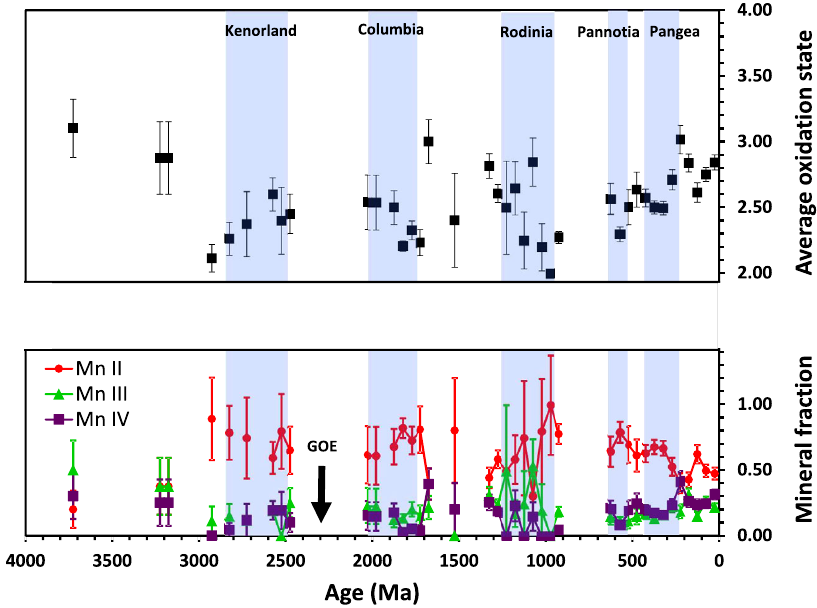
Fig. 2 Individual and average Mn oxidation states as a function of geologic time. Graph of fraction of Mn mineral occurrences (lower) and average Mn oxidation state (upper) as a function of geologic time, with data parsed into 50 million-year bins. Colored symbols indicate oxidation state of Mn; Red circles = Mn(II), Green triangles = Mn(III), Purple squares = Mn(IV). Blue bands represent intervals in which Earth ’ s major landmasses are thought to have consolidated into a supercontinent. Uncertainties for oxidation state fractions are standard deviations calculated as the square root of the number of counts for an oxidation state divided by the total counts for all oxidation states in a given time bin, using an approximation from the negative binomial distribution as described in “ Methods ”